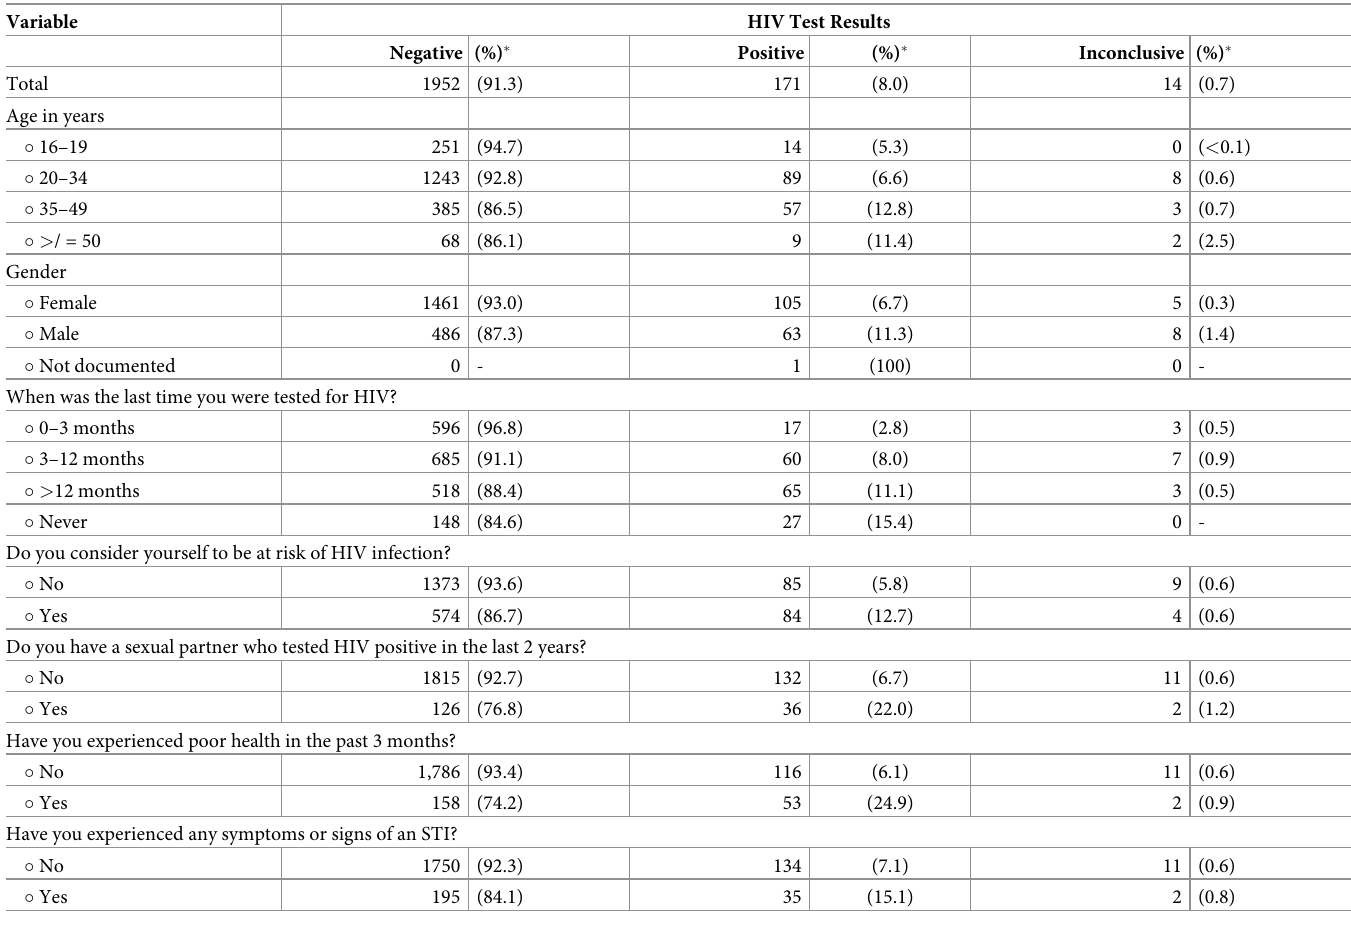
Table 3. HIV test results by category and response to questions for clients screened in Zimbabwe, 2012–16. (N = 2137) #